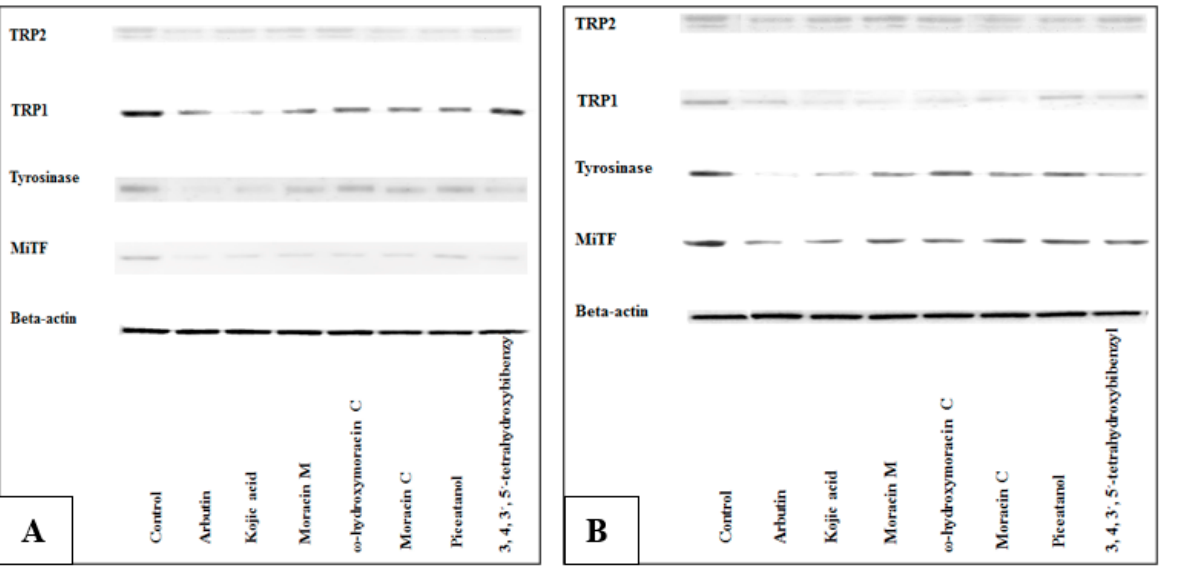
Figure 5. Effect of the isolated compounds from S. taxoides on the melanogenic protein expression in B16-F1 cells. Cells were treated with 25 µg/mL ( A ) and 50 µg/mL ( B ) of the isolated compounds. Whole cell lysates were subjected to Western blot analysis using specific antibodies against MITF, tyrosinase, TRP1 and TRP2.